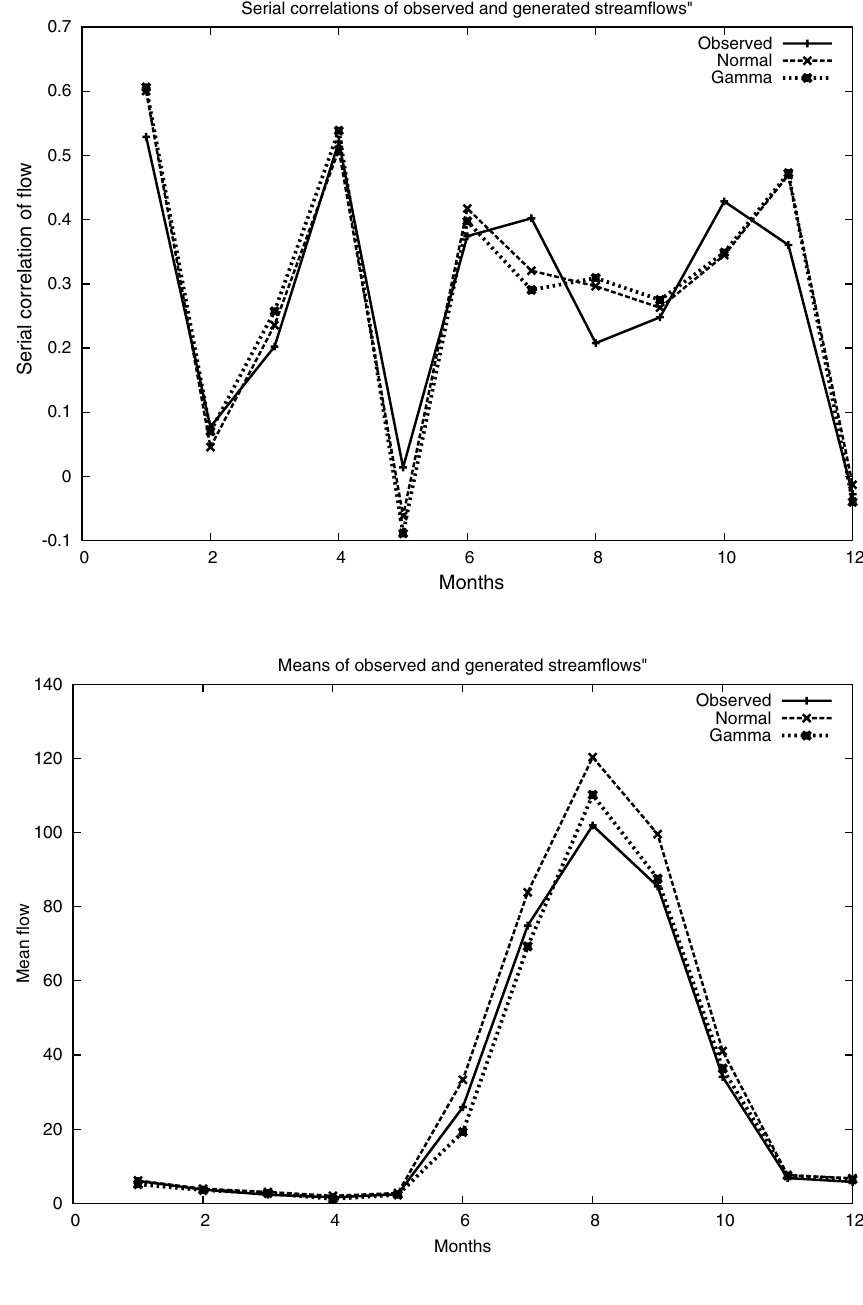
Fig. 5 Historical and generated monthly serial correlations of flows in Konar River (single- site model)